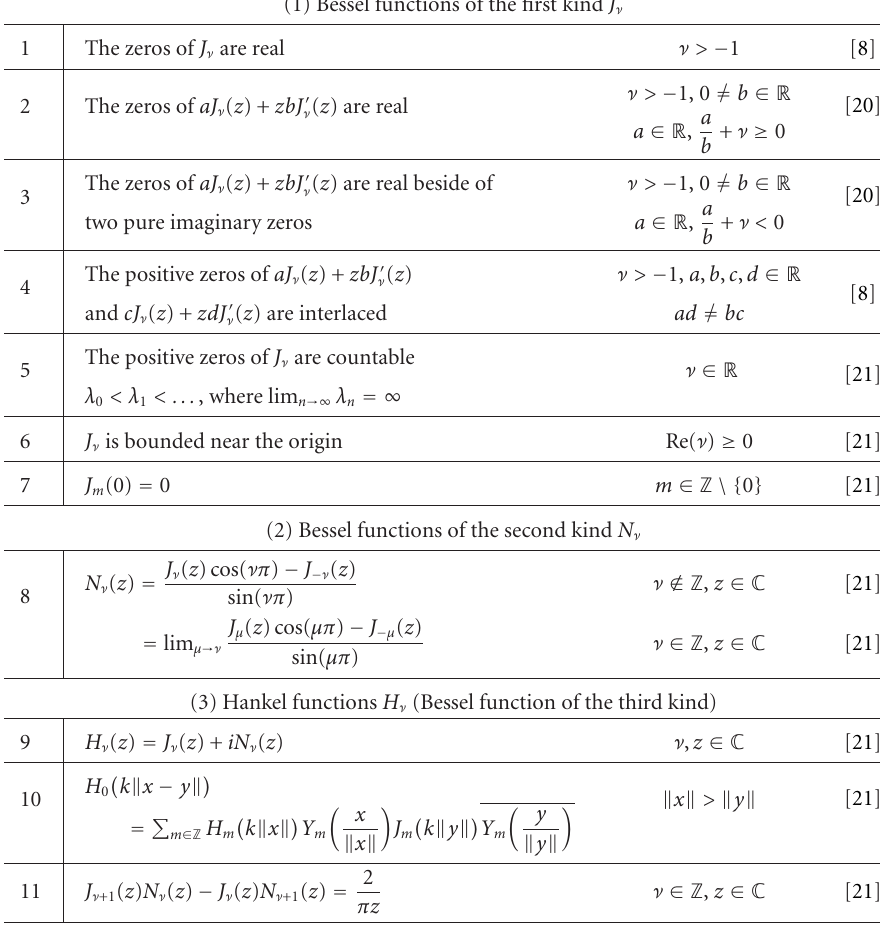
(1) Bessel functions of the first kind J